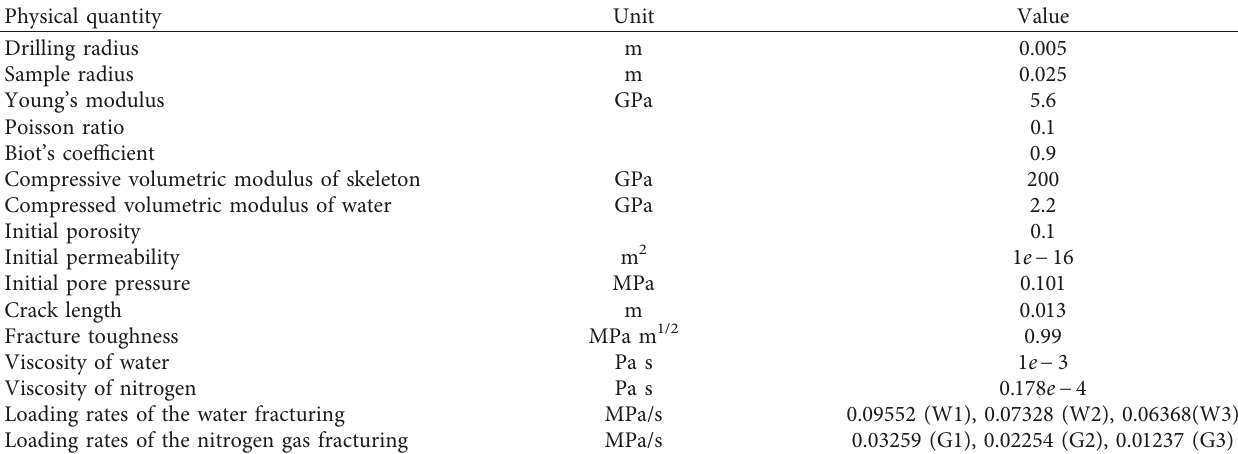
Table 4: Calculation parameters.